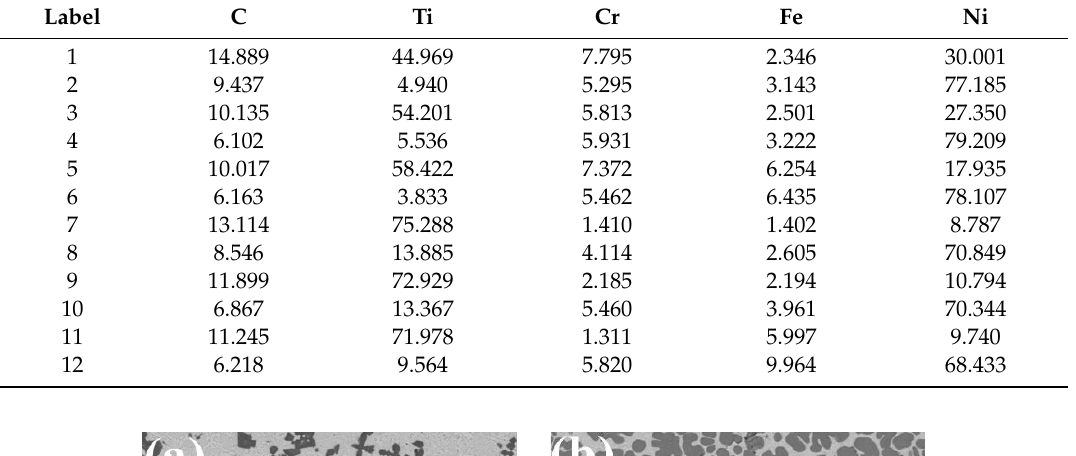
Table 7. Element content table of micro TiC cladding layer structure determination. (Labels 1 – 6 belong to 12# sample, Labels 7 – 12 belong to 11# sample).